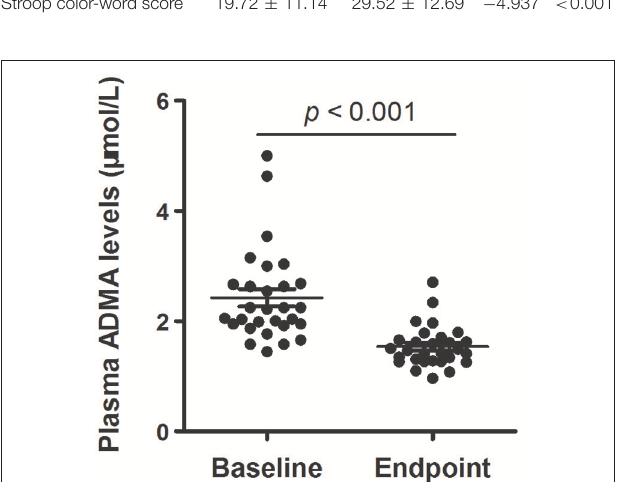
FIGURE 1 | Plasma ADMA levels of schizophrenia patients with acute exacerbation at baseline and endpoint (8th-week). Scatter plot for the comparison of plasma ADMA levels at baseline and endpoint. The sample means are indicated by the black bars.